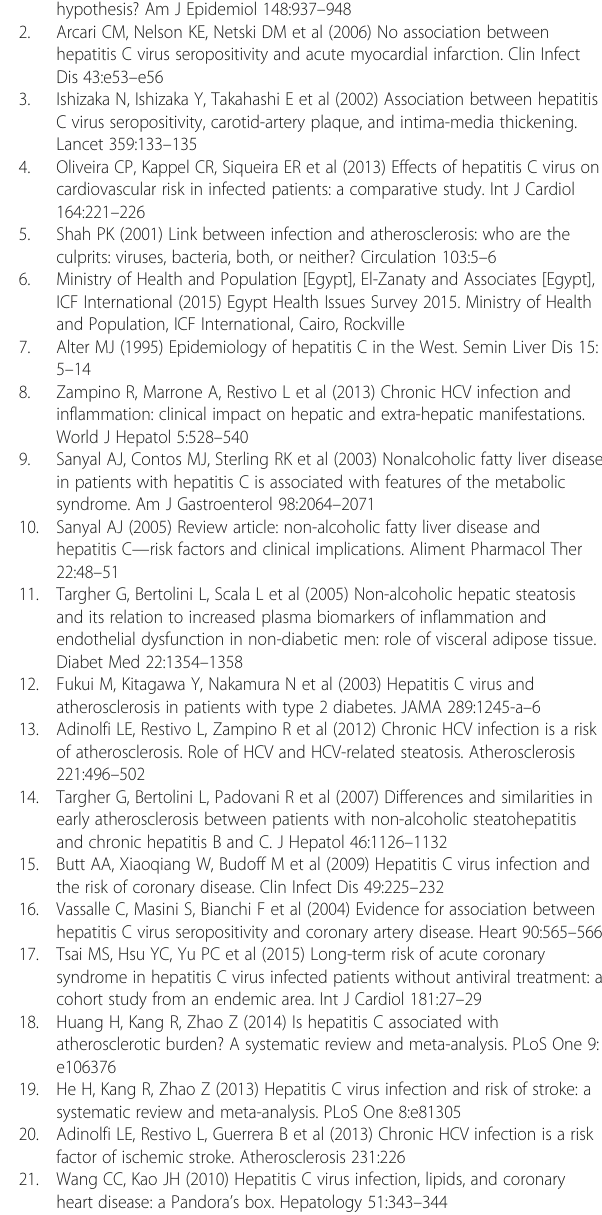
Clinical in-stent restenosis (documented by coronary angiography)